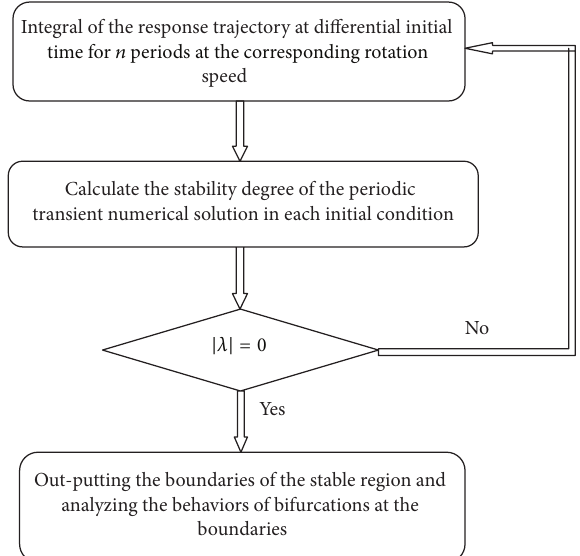
Figure 1: Procedures in estimation of stability of a nonlinear dynamic